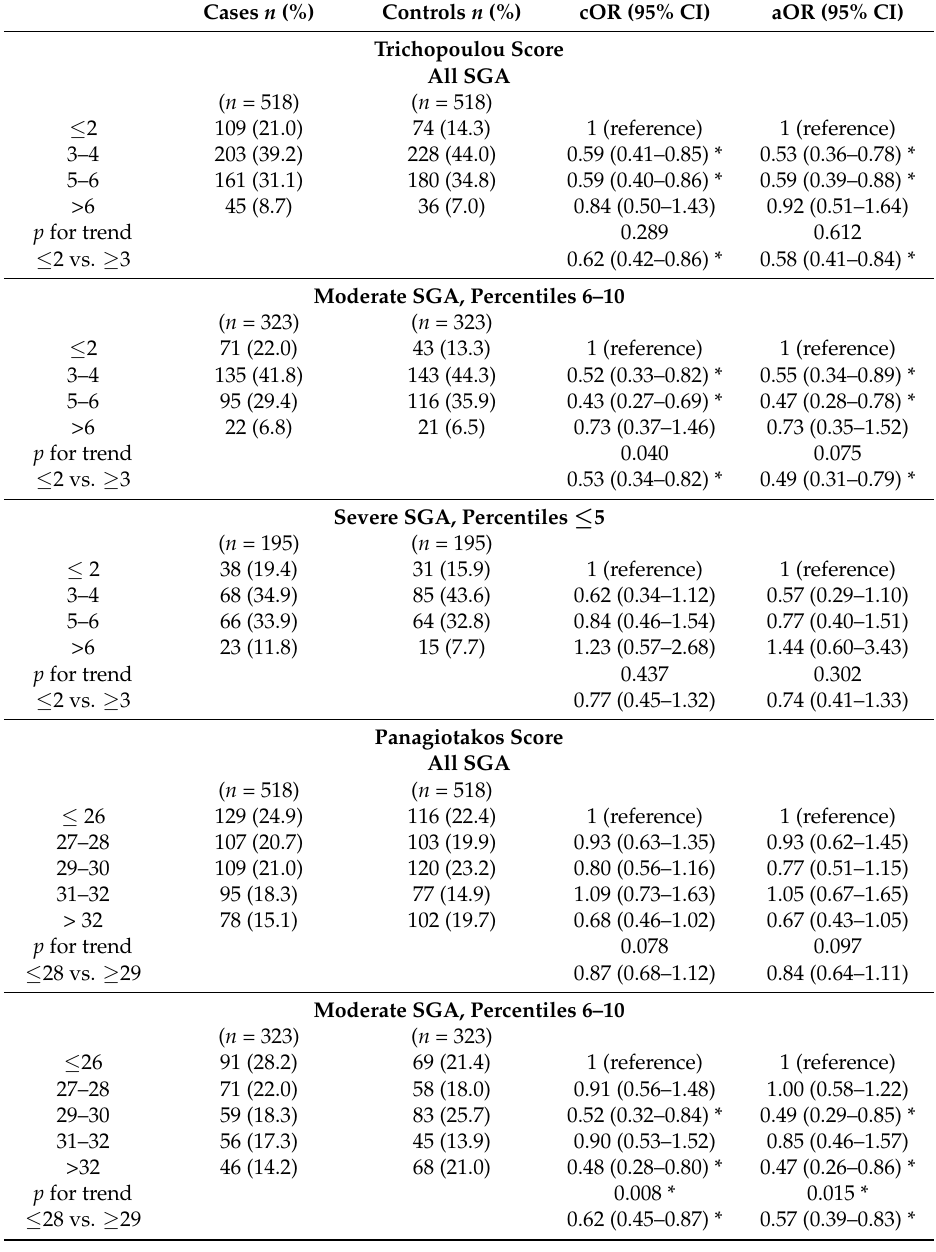
Table 4. Trichopoulou and Panagiotakos scores and risk of SGA for entire sample and stratified on degree of